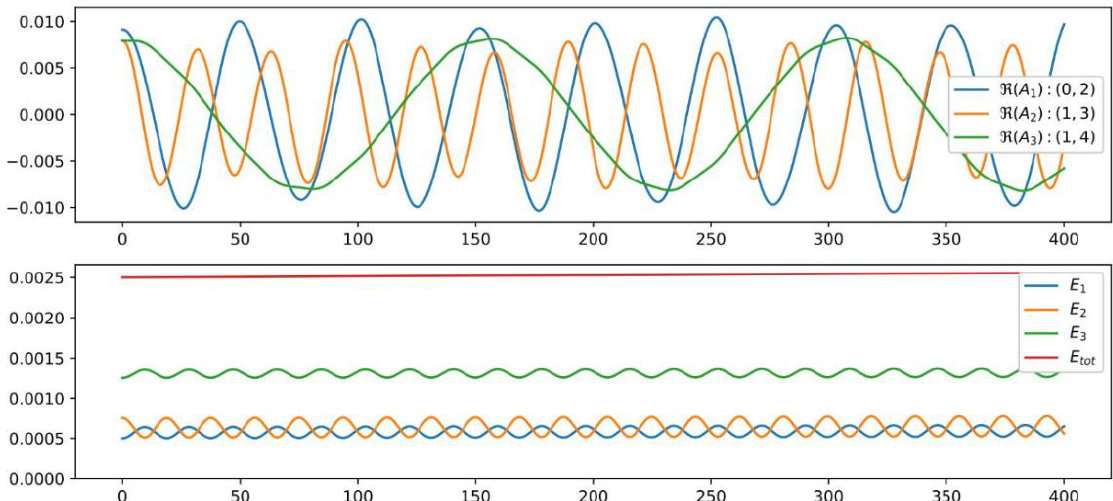
Figure 7. Color online. Time evolution of the amplitude ( top ) and energies ( bottom ) of the modes in the zonal triad (0; 2); (1; 3) → (1; 4) with physical detuning 𝛿 = 0.033333333 and 𝑍 = 7.82.